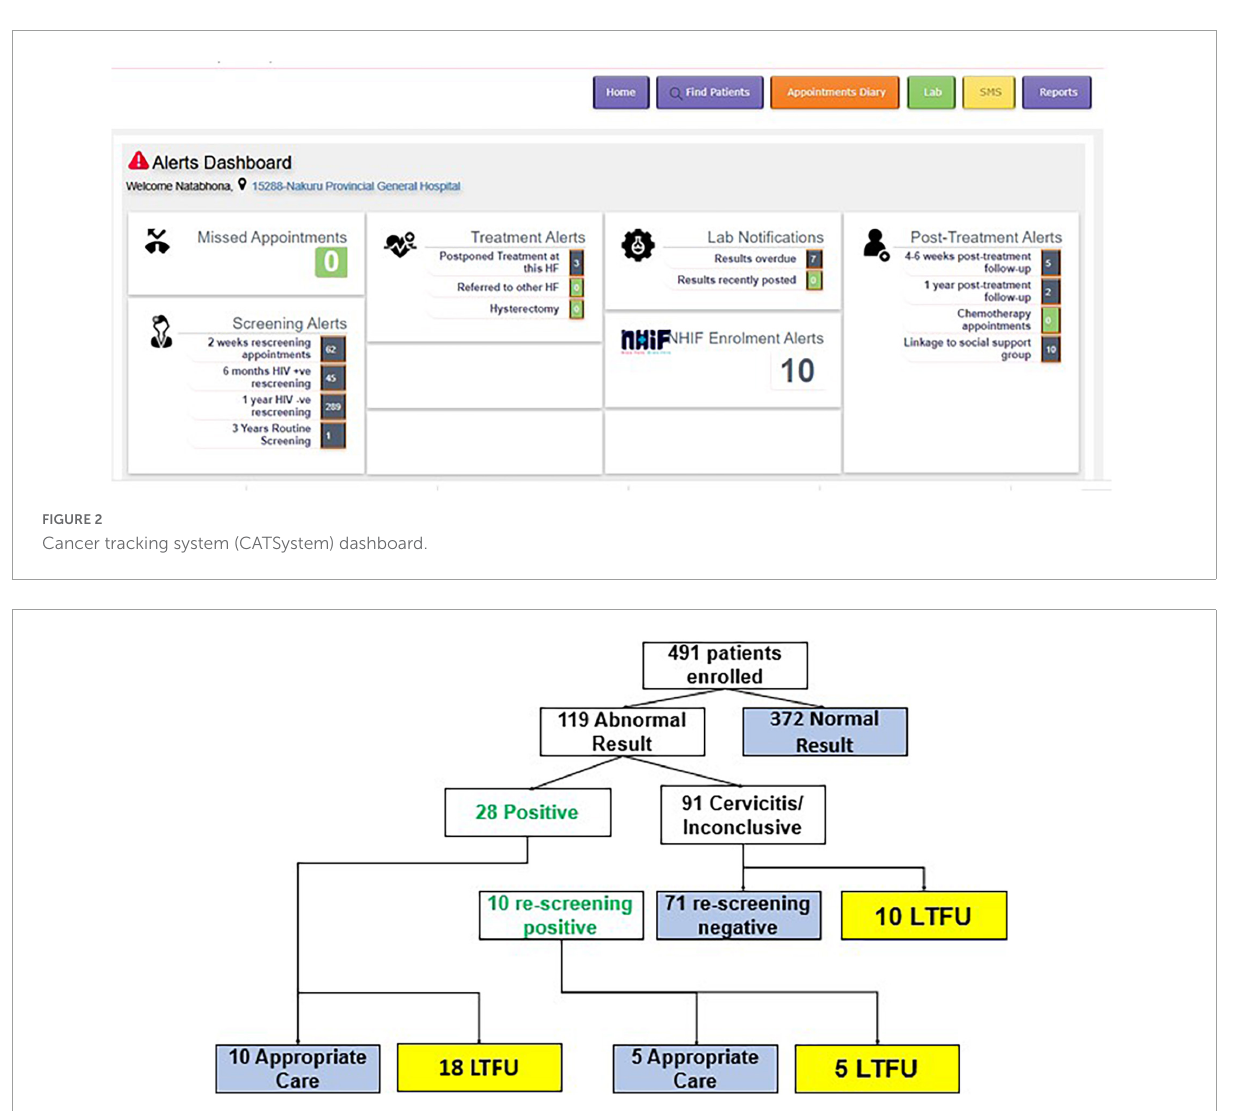
FIGURE3 Flow of cancer tracking system (CATSystem) participants through cervical cancer care. Blue boxes indicate completion of care. Yellow boxes indicate loss to follow up prior to completion of